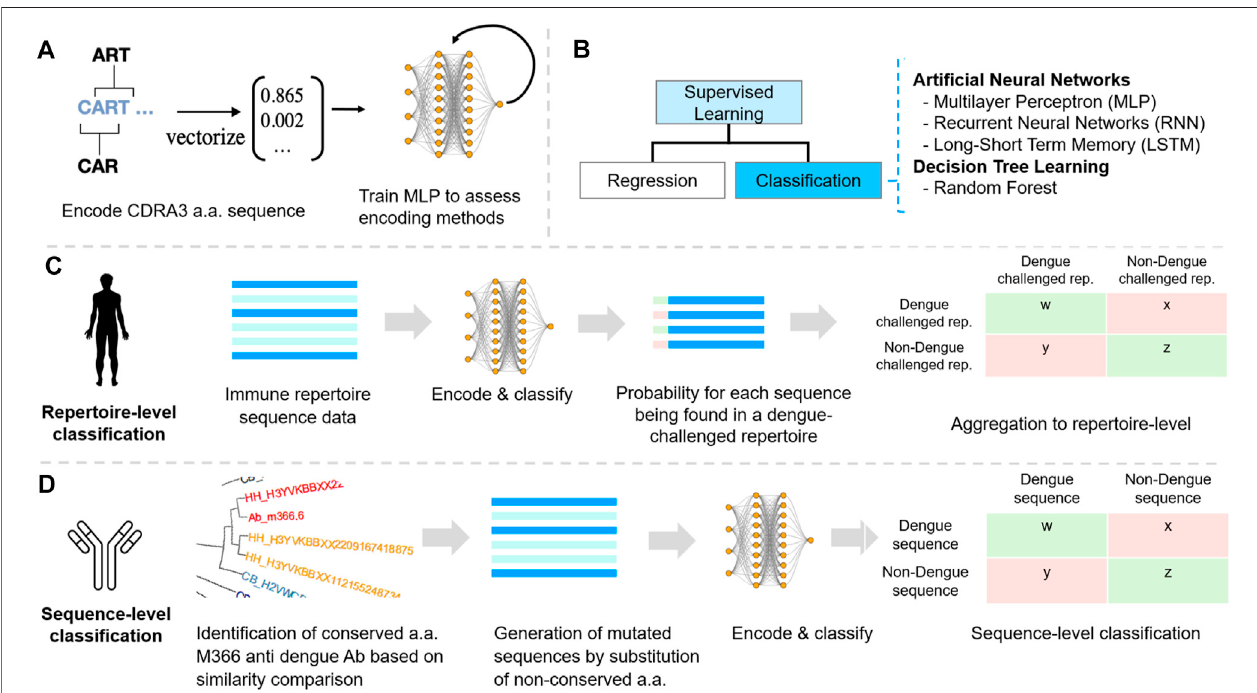
FIGURE 2 | Machine learning reveals dengue-speci fi c antibody sequence signatures at the repertoire and sequence level. (A) Encoding. Five different encoding schemes were benchmarked using a simple multilayer perceptron (MLP). (B) Classi fi cation of CDR3 sequences was performed using supervised machine learning classi fi cation as for each repertoire and sequence the label (dengue/non-dengue) was known. (C) Dengue datasets were annotated using IgBAST and preprocessed in R (see Methods). Labelled (dengue/background) CDR3 sequences were subsequently encoded. ML models were tuned, trained, and compared with regard to accuracy, sensitivity, speci fi city, and ef fi ciency at the repertoire-level and sequence-level classi fi cation. (D) Sequence classi fi cation was performed based on bNAb sequences and constructing de novo bNAb networks to detect extended sequence-patterns in repertoires. Benchmarking various encoding